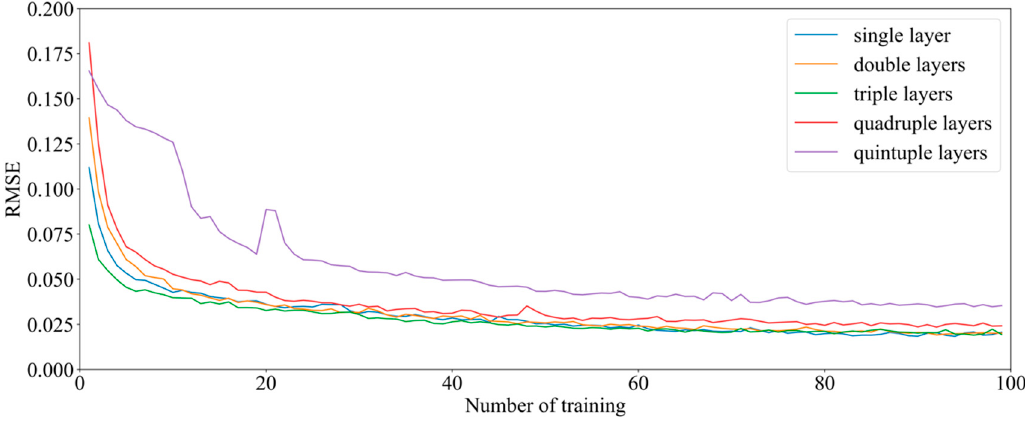
Figure 9. The training error under different layers.